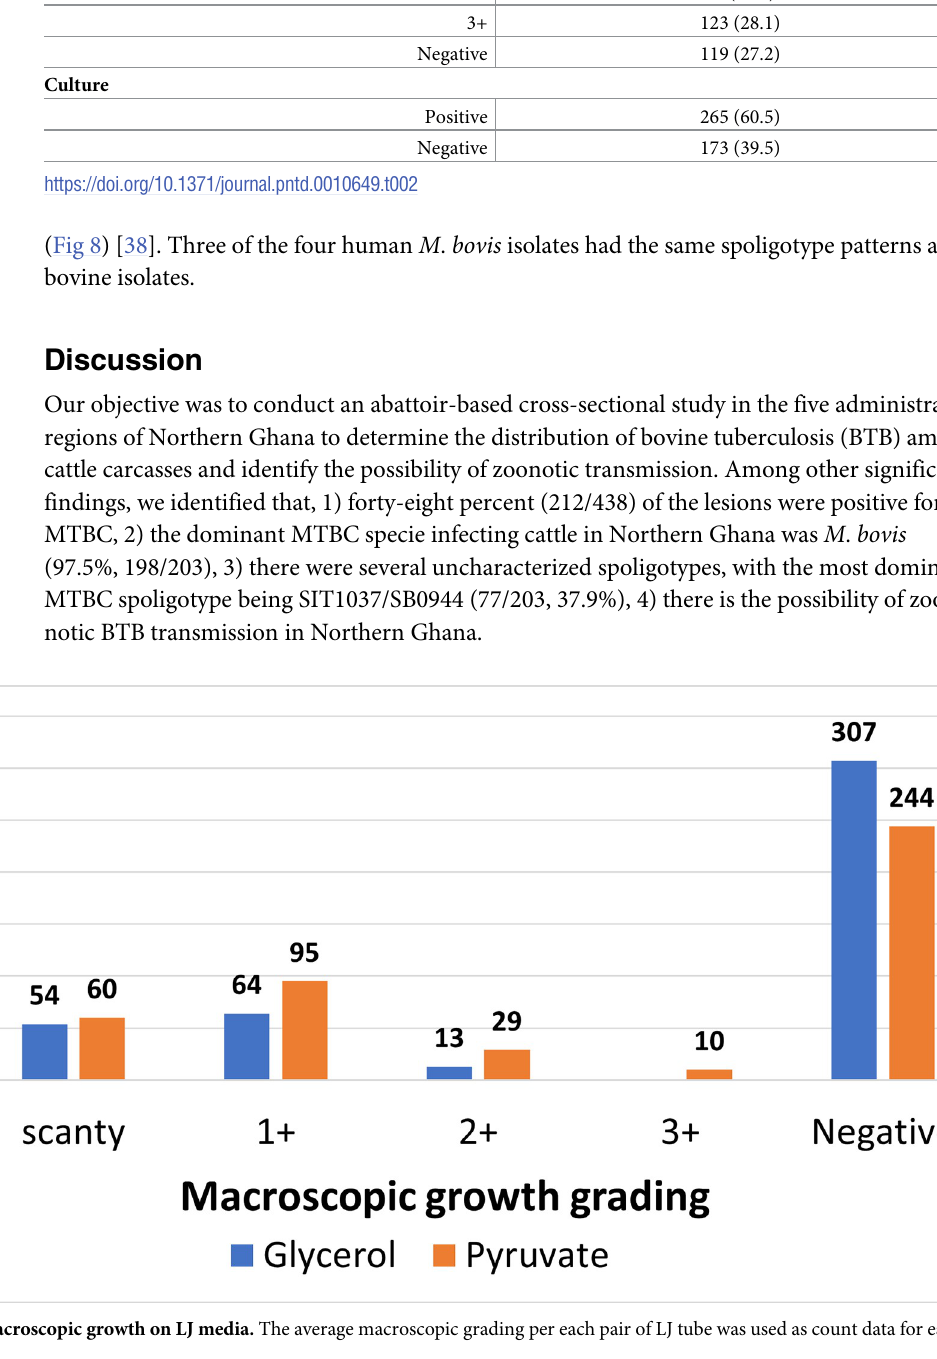
Table 2. Microscopic and culture examination of sample homogenates.